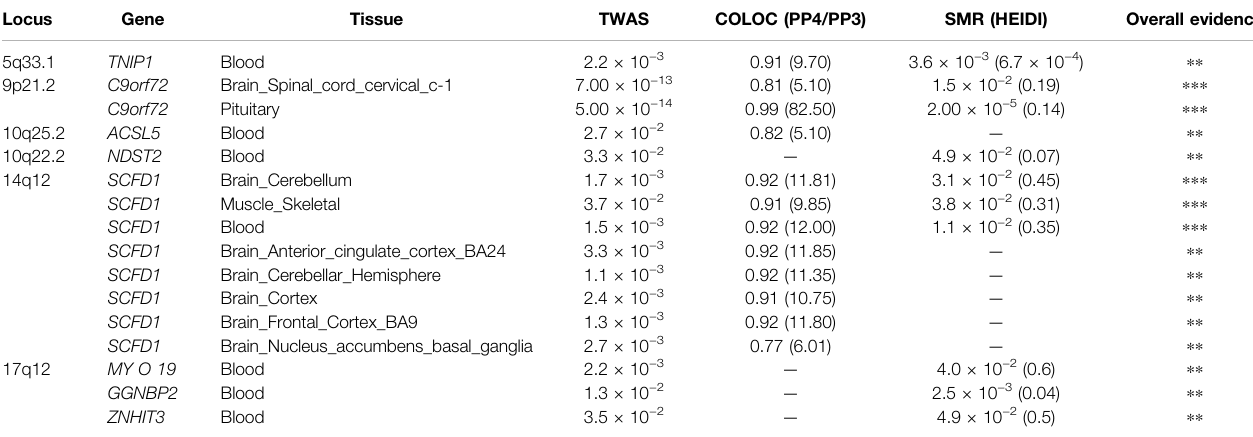
TABLE 2 | Integration of TWAS, COLOC, and SMR results.